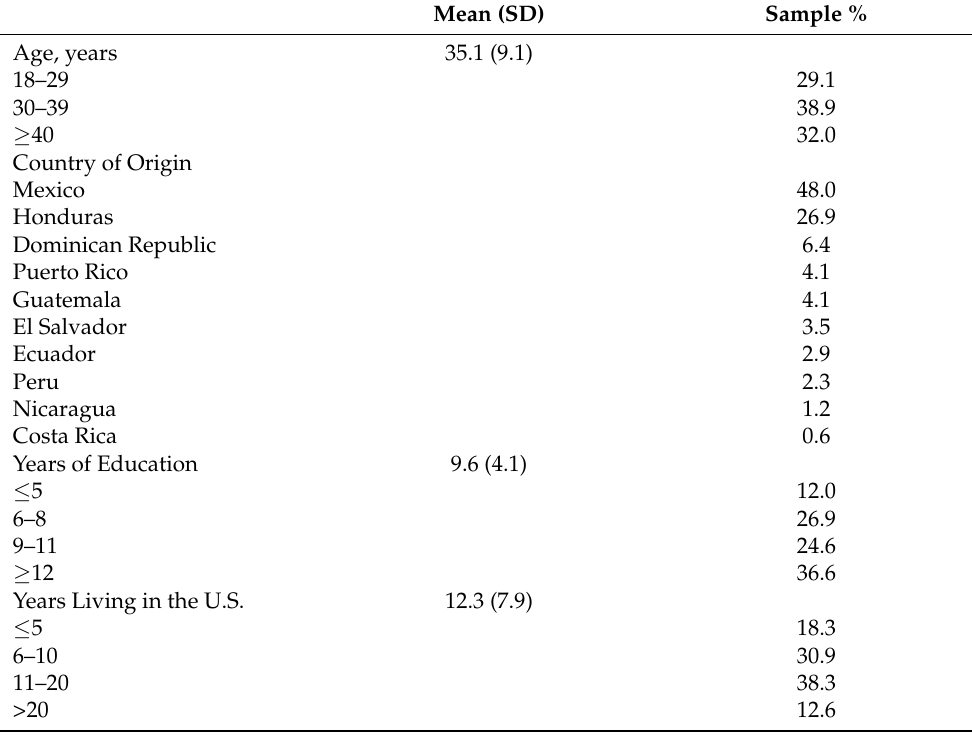
Table 1. Characteristics of the study sample (N =